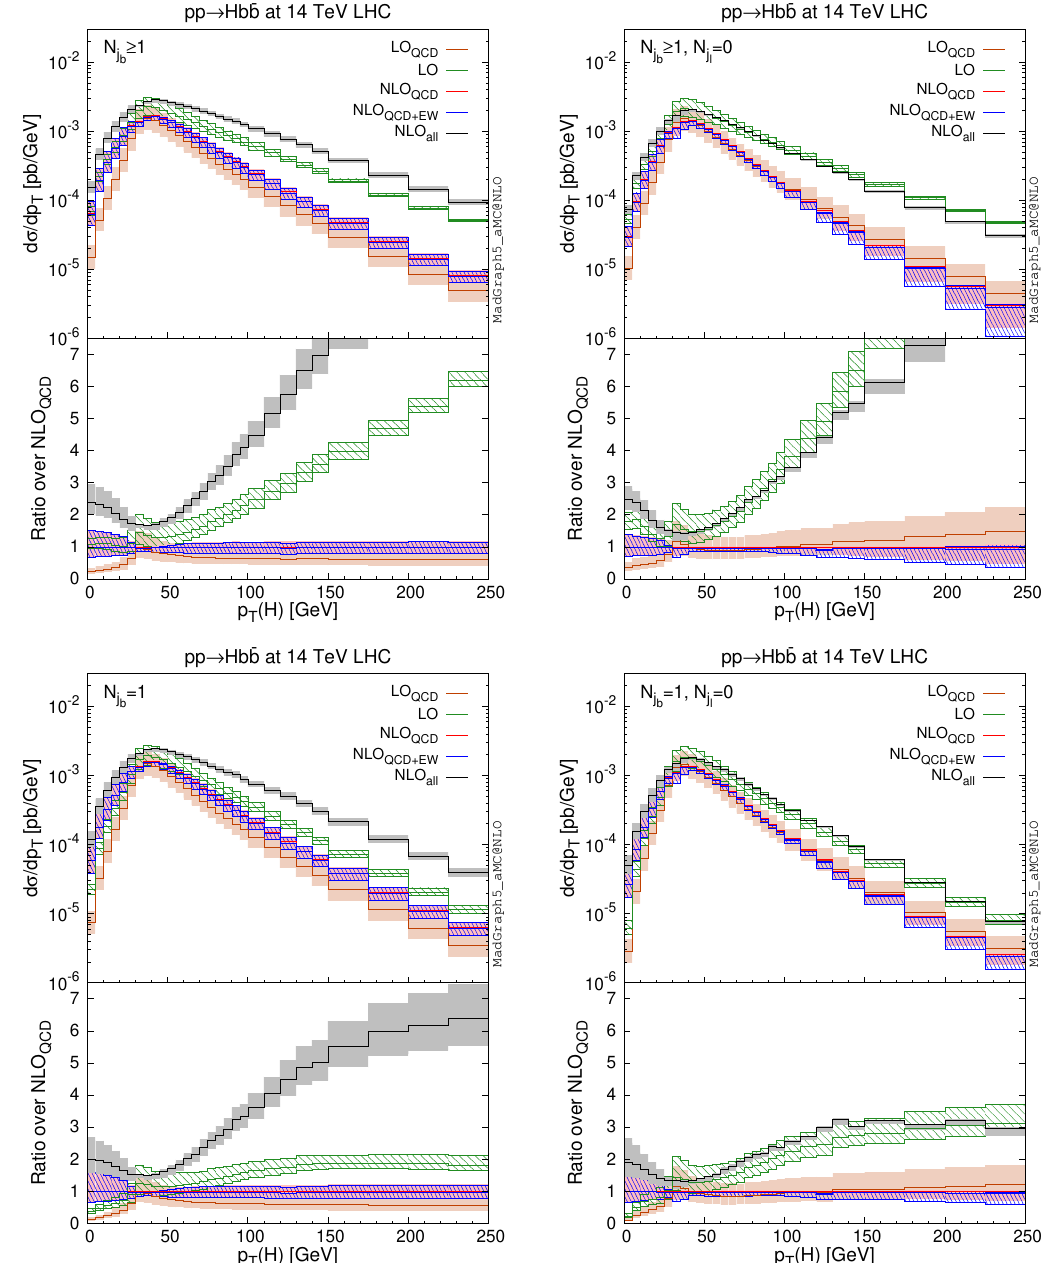
Figure 5 . The p T ( H ) distribution for N j light-jet veto is